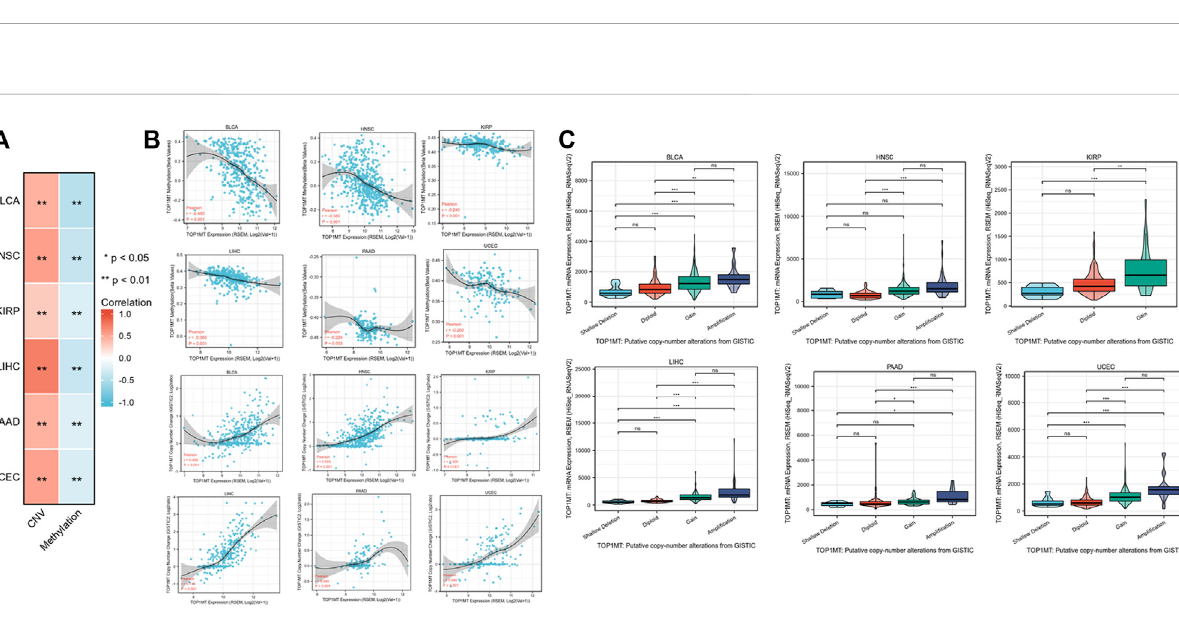
FIGURE 6 CNA and DNA methylation of TOP1MT in human cancer. (A,B) Linkedomics analysis correlation analysis between TOP1MT expression and TOP1MT methylationlevelandcopynumbervariationdatalevel; (C) cBioPortalanalysisof TOP1MT CANdataindifferentcancerstudies. p p < 0.05, pp p < 0.01 and pp p <